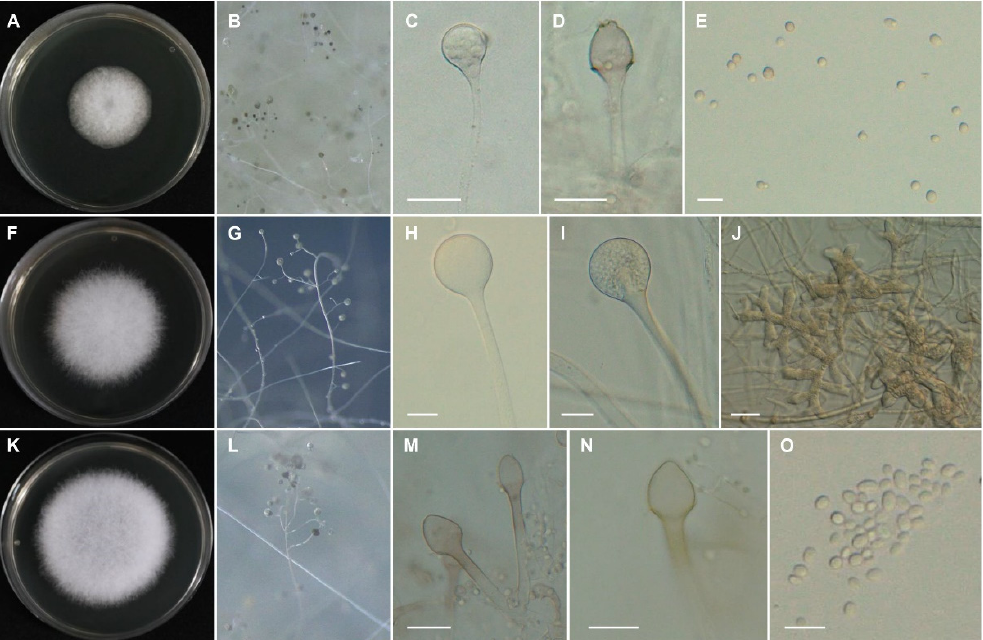
Figure 3. Morphology of Lichtheimia spp. Lichtheimia hyalospora CNUFC CY2246 ( A – E ) [( A ) colony on MEA at 35 °C. ( B ) sporangiophores with sporangia observed under stereomicroscope. ( C ) sporangium. ( D ) columella with projection. ( E ) sporangiospores]. Lichtheimia ornata CNUFC S817 ( F – J ) [( F ) colony on MEA at 35 °C. ( G ) sporangiophores with sporangia observed under stereomicroscope. ( H,I ) young and mature sporangia. ( J ) giant cells formed on PDA]. Lichtheimia ramosa CNUFC CY2219 ( K – O ) [( K ) colony on MEA at 35 °C. ( L ) sporangiophores with sporangia observed under stereomicroscope. ( M, N ) columellae with and without collars. ( O ) sporangiospores]. Scale bars: C, D, H, I, M, N = 20 μ m, E, O = 10 μ m, J = 50 μ m.